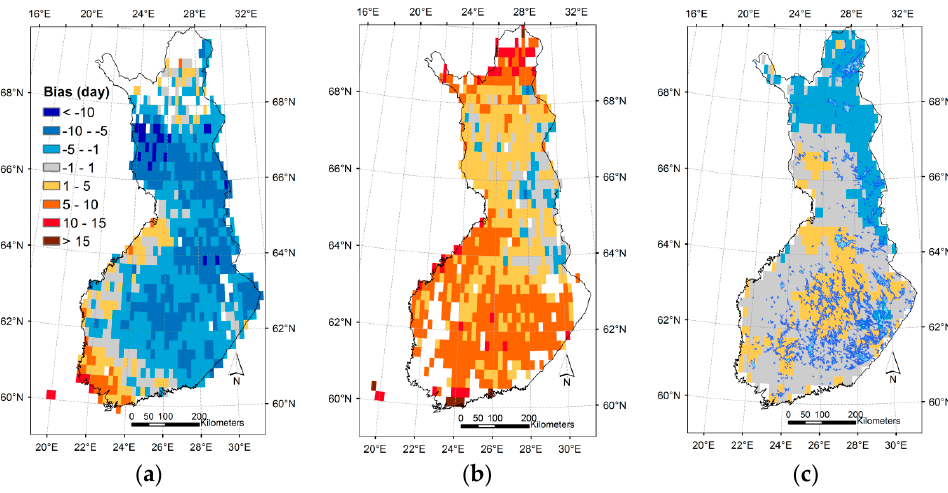
Figure 8. Grid cell-wise bias between start of season derived from the JSBACH model and remote sensing in Finland for the period 2003–2010: ( a ) in evergreen needle-leaf forest; and ( b ) in deciduous broad-leaf forest; ( c ) Bias in JSBACH-modelled starting date of the “growth phase” of DBF because of the driving temperature data. The bias was calculated as the difference in the start date of the “growth phase” simulated by running the LoGro-P-model with regional climate model data and with gridded temperature observations. Red colours show areas with a late bias and blue areas indicate an early bias of the modelled date.